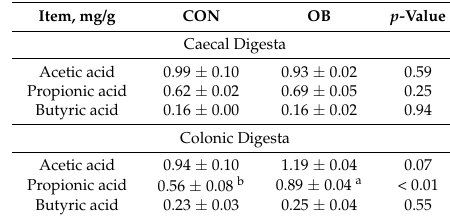
Table 4. Short chain fatty acid (SCFA) concentrations in the caecal and colonic digesta of pigs fed either control or oat bran diet 1 .